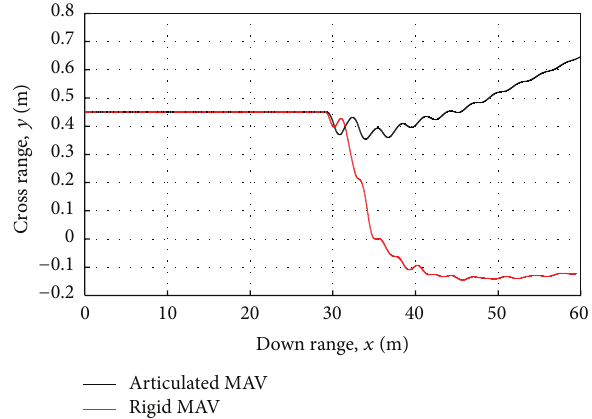
Figure 12: Rigid and articulated MAV trajectory in response to a 3m/s crosswind